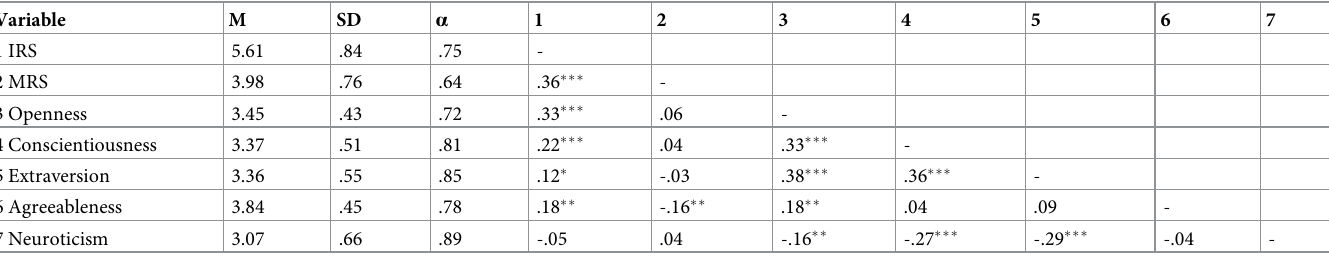
Table 2. Means, Standard deviations, Chronbach’s Alphas, and zero-order correlations (Study 2). Variable